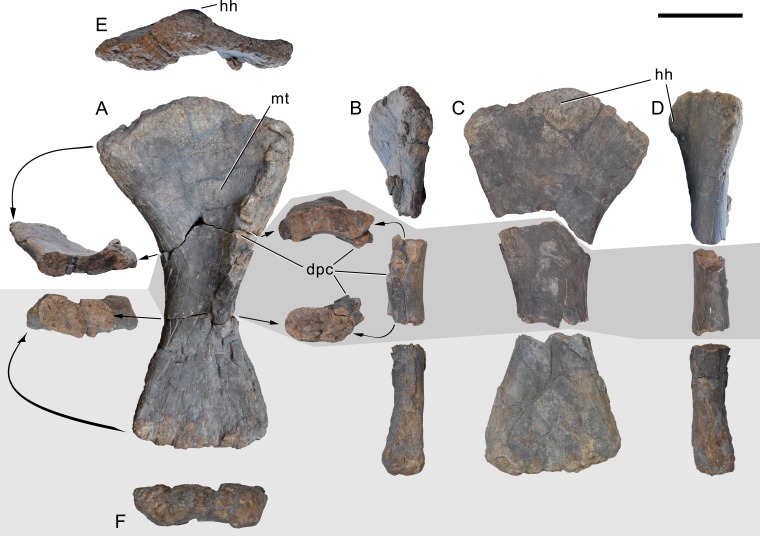
Left humerus of Galeamopus pabsti SMA 0011.The humerus is shown in anterior (A), lateral (B), posterior (C), medial (D), proximal (E), and distal (F) view. Cross-sections of the disassembled pieces are shown as well. Note the rugose tubercle on the anterior surface of the proximal half of the shaft (mt). Abb.: dpc, deltopectoral crest; hh, humeral head; mt, median tubercle. Scale bar = 20 cm.